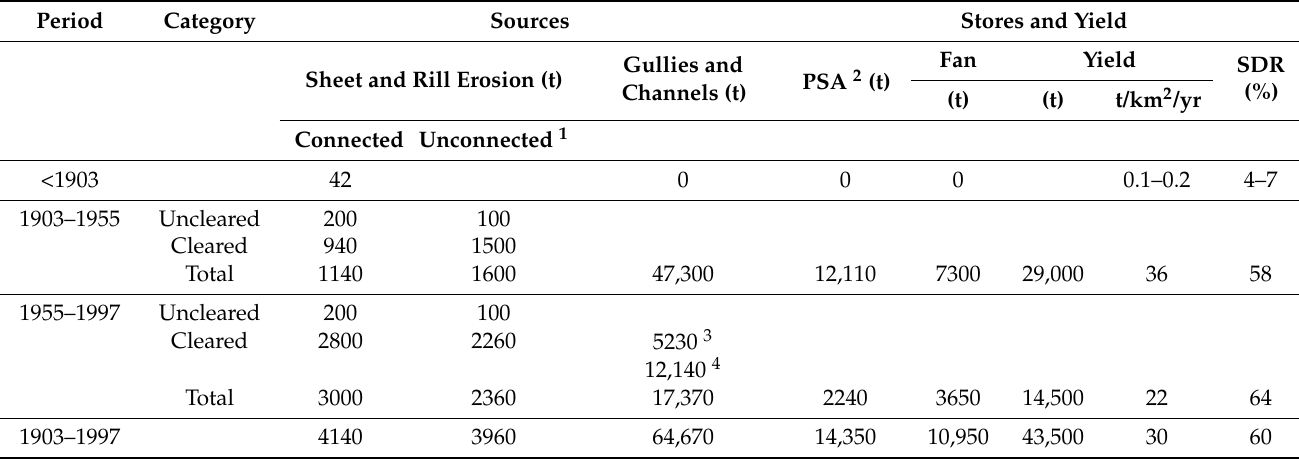
Table 2. Sediment Budgets for the Takalarup